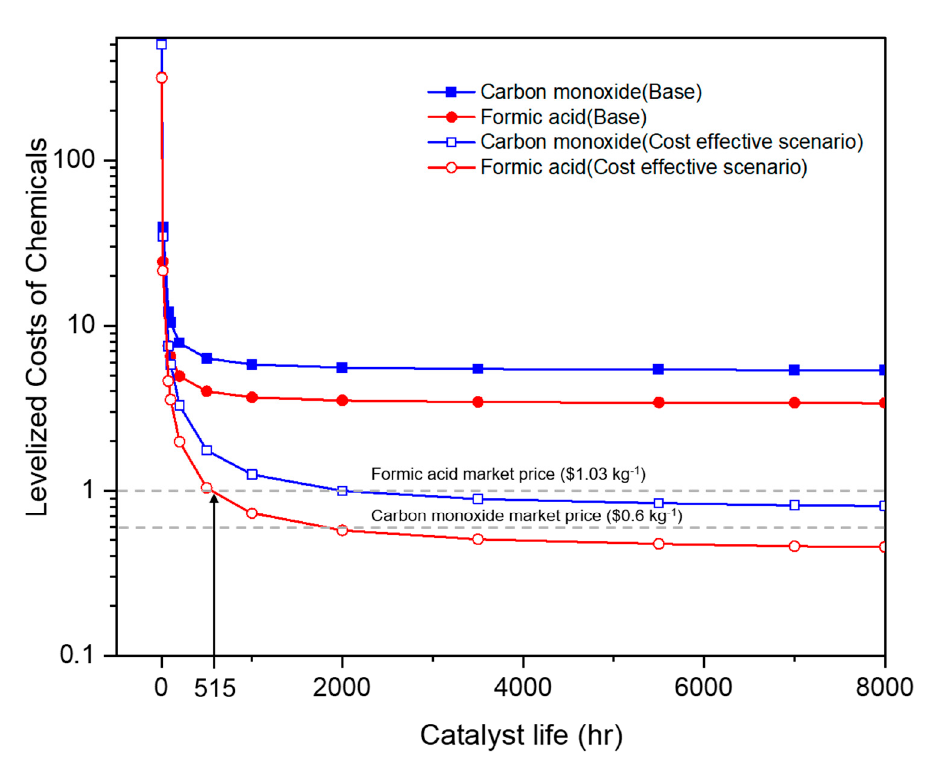
Figure 8. A techno-economic analysis of carbon monoxide and formic acid production via the electrochemical CO 2 -reduction process throughout the catalyst’s operative life under different scenarios. The process models and parameters of analysis are based on Na et al. [7].